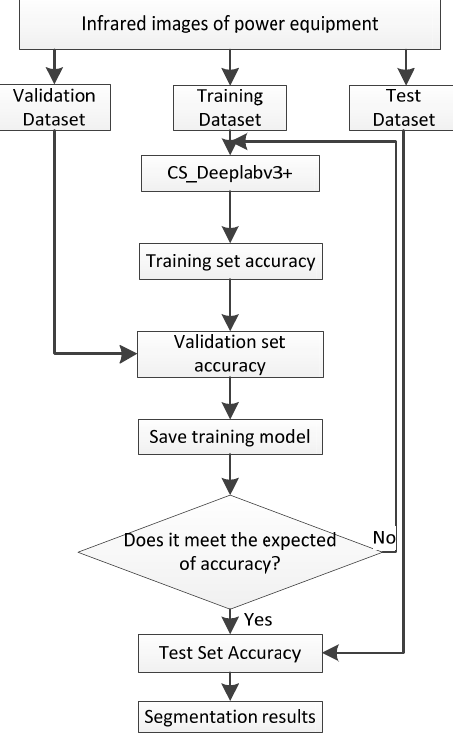
Figure 1. Algorithm flow chart